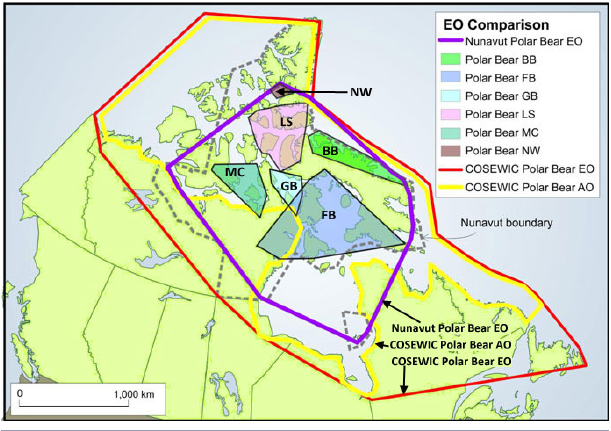
Fig. 5 . Comparison of Inuit knowledge (IK) extent of occurrence (EO) for polar bear ( Ursus maritimus ) designatable units with IK Nunavut EO and Committee on the Status of Endangered Wildlife in Canada (COSEWIC) EO and area of occupancy (AO; COSEWIC 2008).